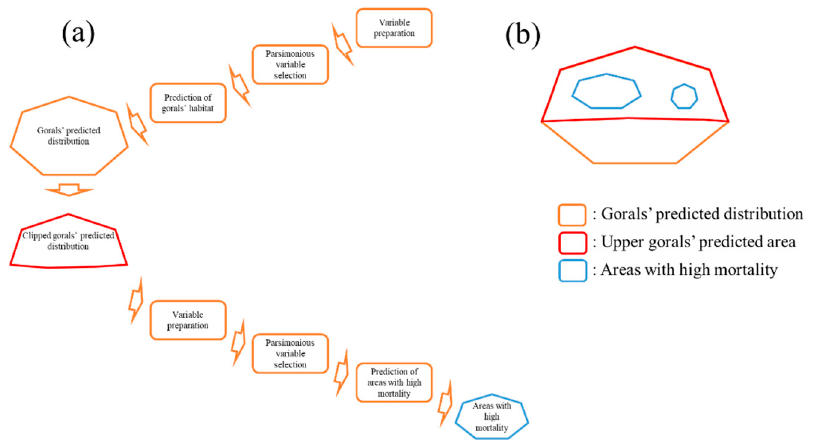
Figure 3. ( a ) Procedures of ensemble species distribution modeling to predict the potential distribution of gorals (orange polygon) and areas with a high mortality rate (blue polygons). ( b ) An example of the predicted habitat of the gorals and areas with a high mortality rate.